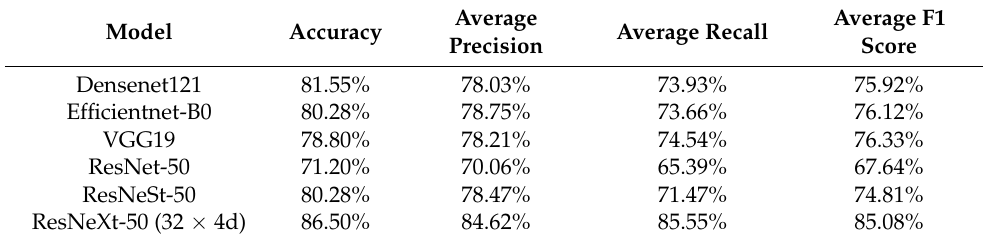
Table 3. The comparison among different proposed